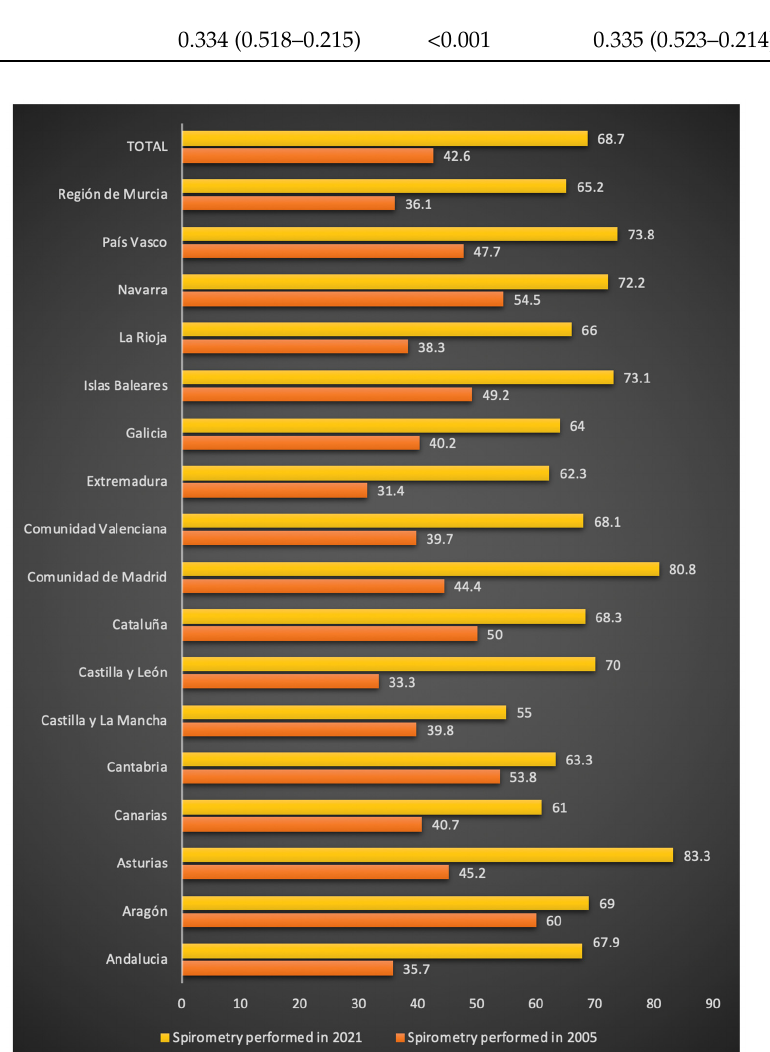
Figure 3. Use of spirometry in subjects with chronic respiratory symptoms in the Spanish population interviewed in 2005 and 2021. Data are expressed in frequencies (%). Table 4. Factors associated with the use of spirometry among subjects with respiratory symptoms who visit a doctor. Multivariate analysis. OR (95% CI)